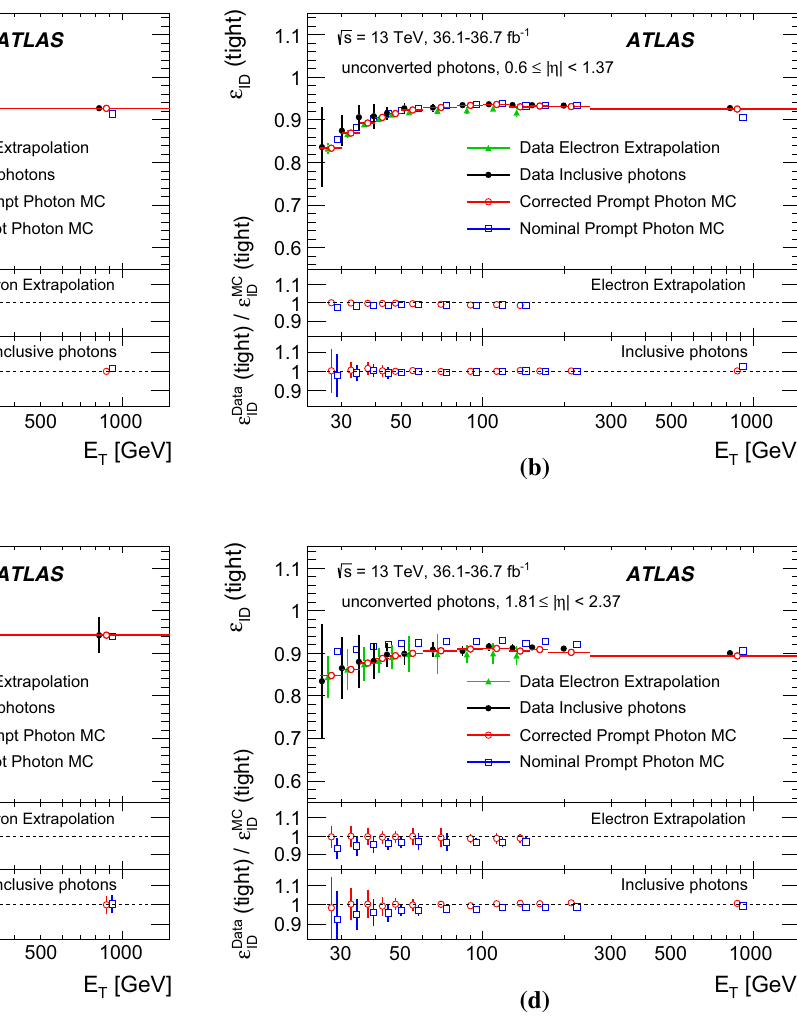
1 . 52 ≤ | η | < 1 . 81, and d 1 . 81 ≤ | η | < 2 . 37. Predictions are shown for both the nominal simulation and with the corrections described in Sect. 4.1. The bottom panels show the ratio of the data-driven values to the MC predictions (referred to as scale factors in the text). The last bin extends to 1.5 TeV